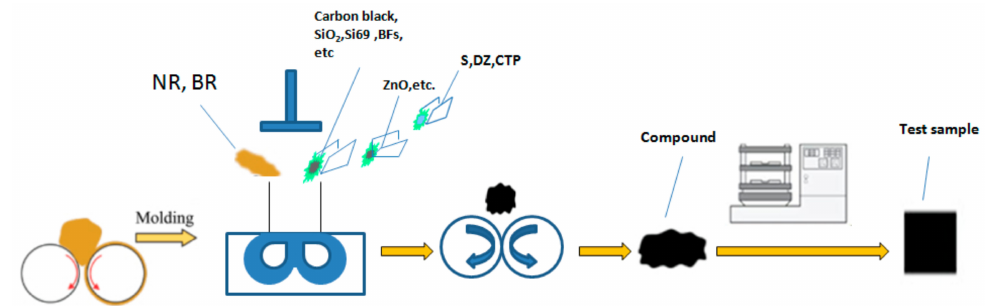
Figure 3. Preparation of different compounds. Table 1. The mass fraction of each component in the delayed formula and all-steel tire formula in the experiment. Delayed Formula Formulation (phr) All-Steel Tire Formula Formulation (phr) NR 85 NR 100 BR 15 Plasticizer 0.08 Carbon black N234 43 Carbon black N234 45 ZnO SAD Microcrystalline wax Microcrystalline wax